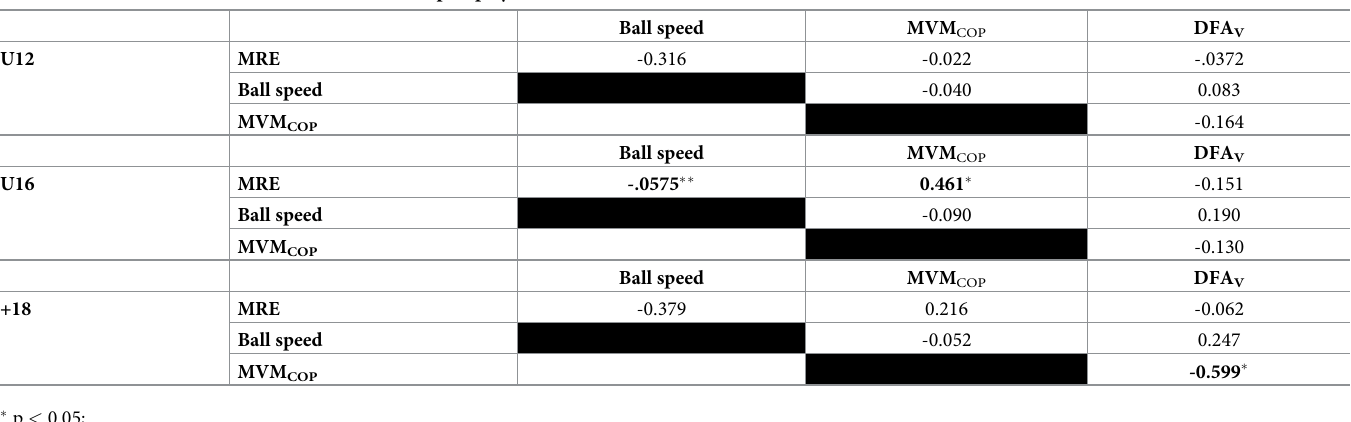
Table 3. Correlations between all the variables for expert players.